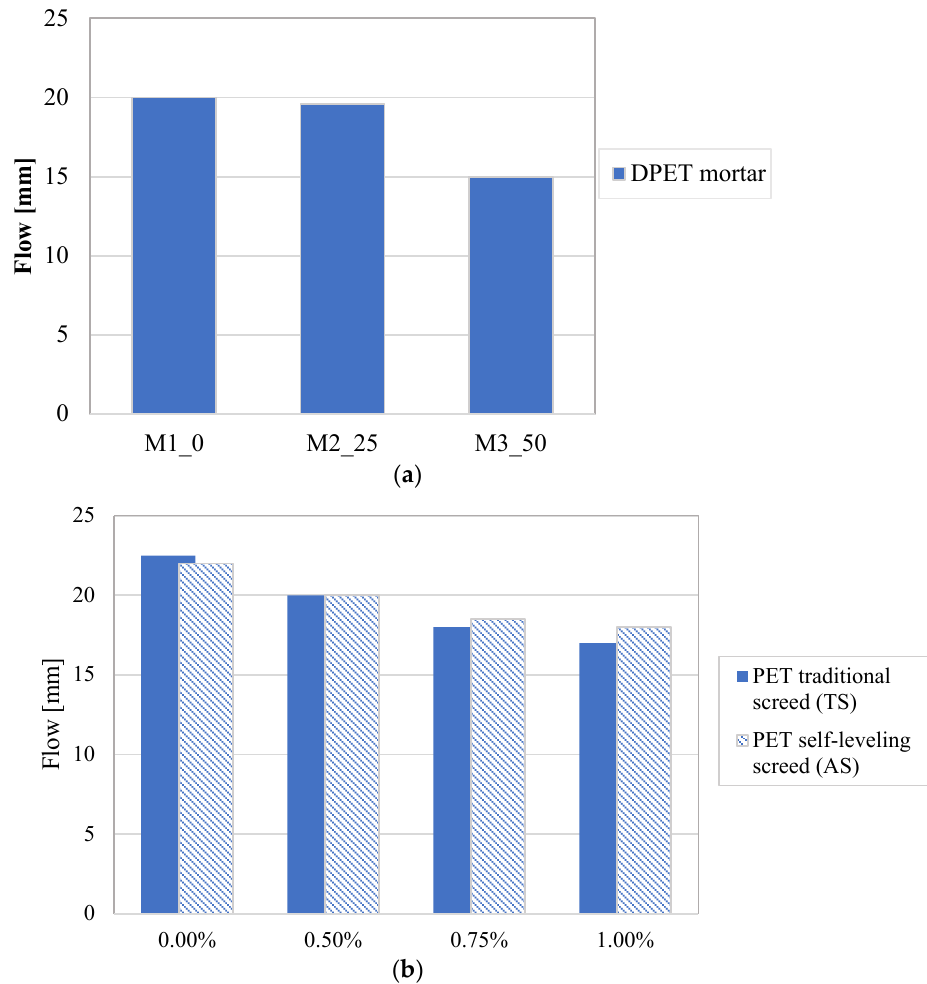
Figure 4. Flow results: ( a ) DPET-mortars; ( b ) PET-fiber screeds. Table 4. Specific weight, thermal conductivity, and diffusivity values of DPET mortars and PET-fiber screeds